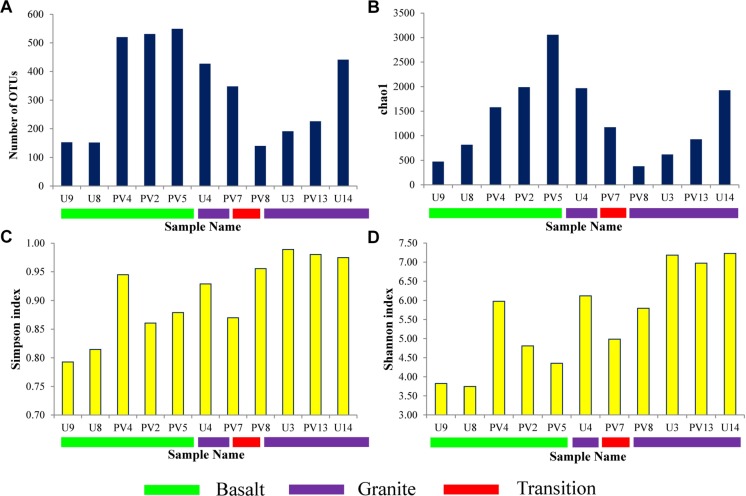
Alpha diversity parameters of different samples. (A) Observed OTUs, (B) Chao1 estimator, (C) Simpson Index, and (D) Shannon Index.